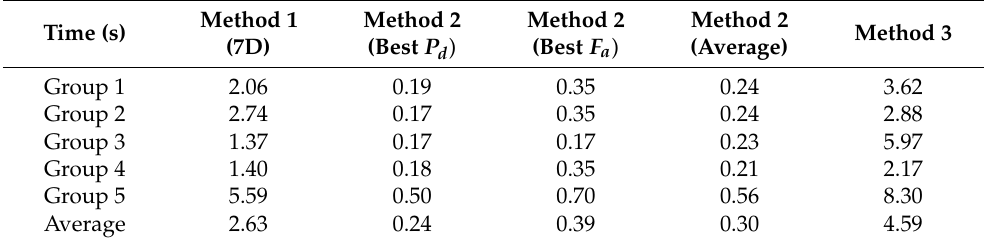
Table 5. Running time of the proposed method obtained by the three